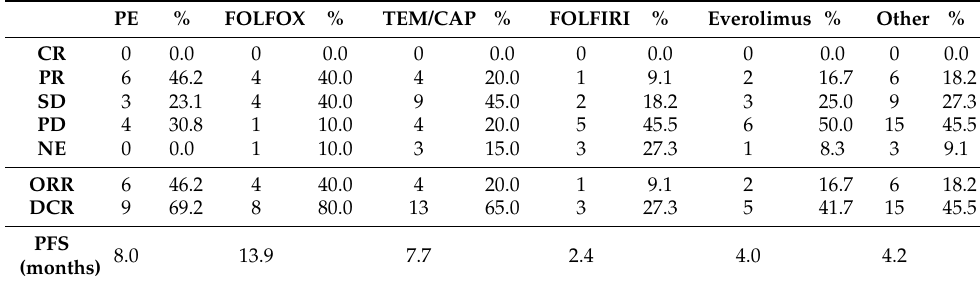
Table 5. Efficacy of second-line